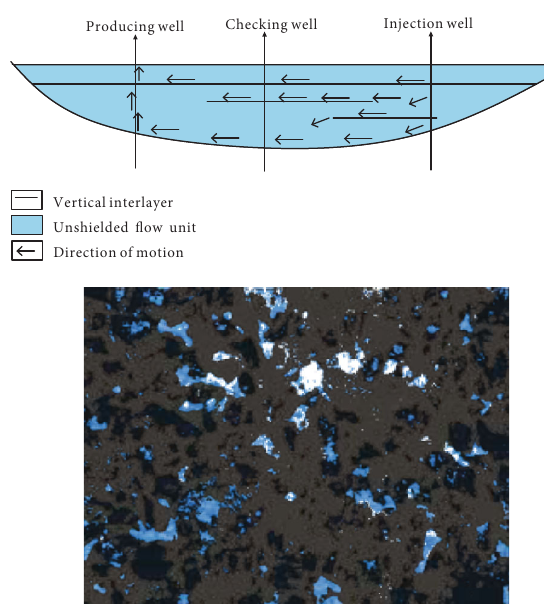
Figure 21: Unshielded fl ow unit microscopic remnant oil model in the narrow channel. White areas represent microscopic remnant oil; black to gray areas represent mineral particles, and blue areas represent foggy-shaped remnant oil.